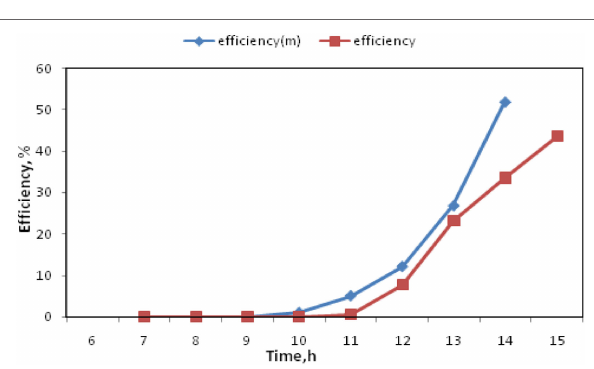
FIGURE 6 | Hourly efficiency curve modified solar still and conventional solar